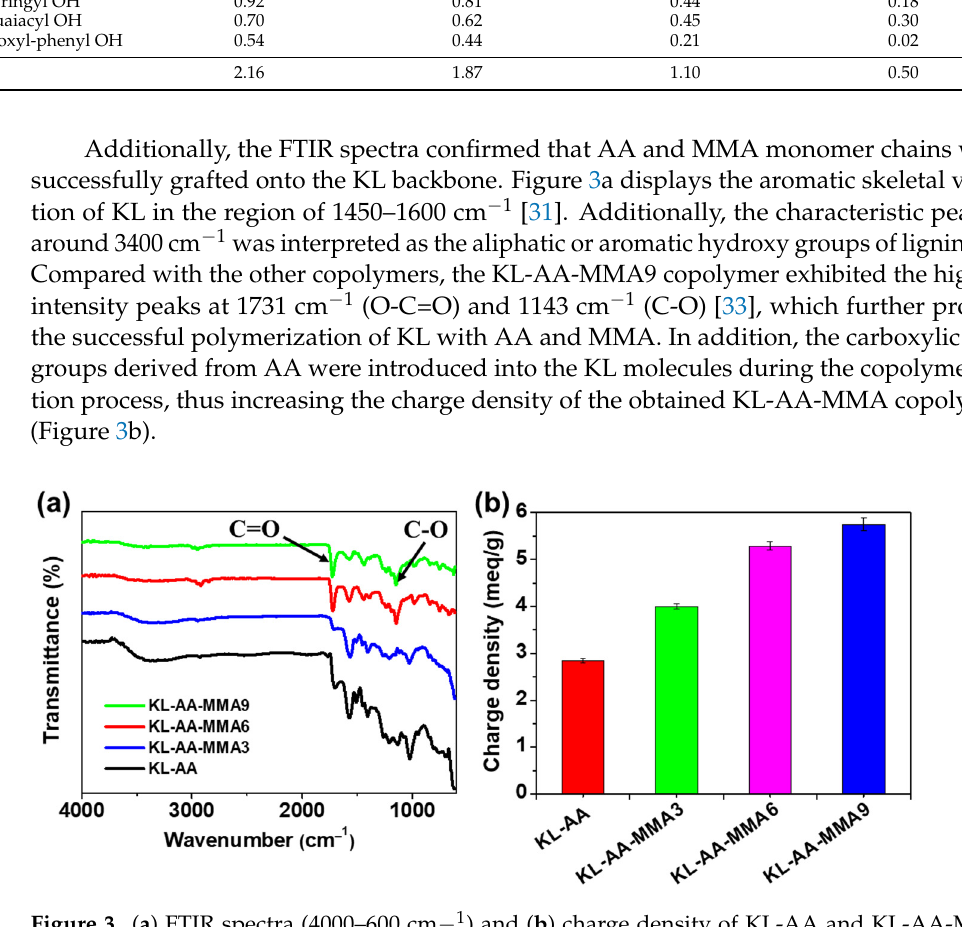
Figure 3. ( a ) FTIR spectra (4000–600 cm − 1 ) and ( b ) charge density of KL-AA and KL-AA-MMA co- polymers.